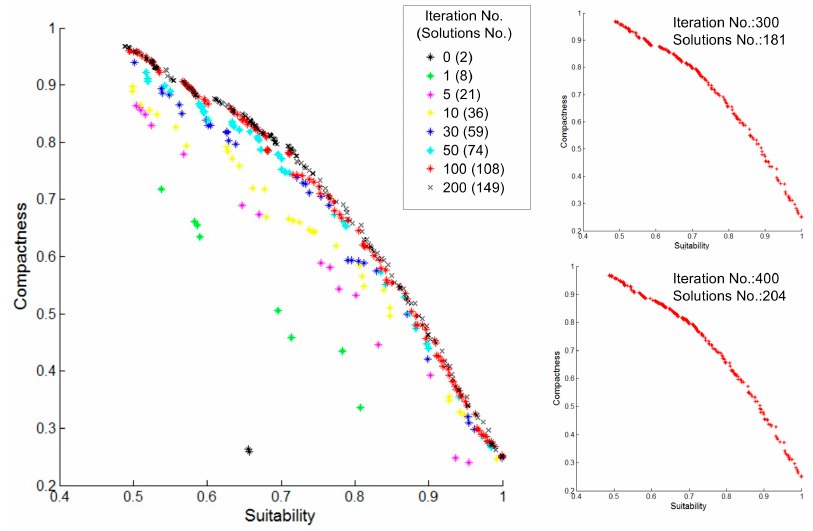
Figure 15. Pareto solutions for different numbers of iterations.